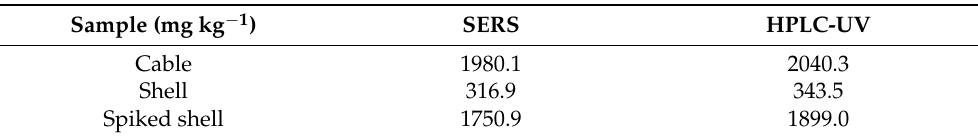
Table 1. TBBPA contents in the mouse and its spiked sample determined by SERS and HPLC- UV